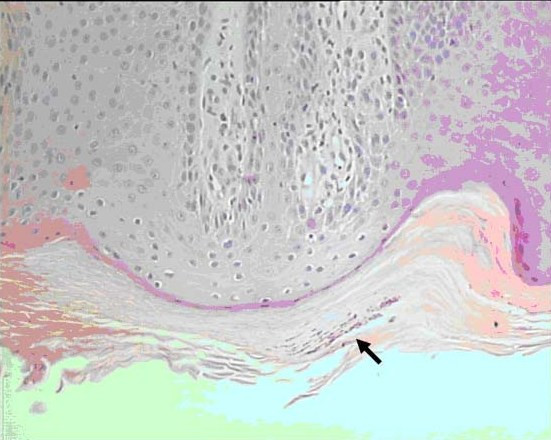
A skin biopsy reveals acanthosis of epidermis, with elongated rete ridges, thin suprapapillary epidermal plates, absent granular layer and hyperkeratosis. A Munro microabscess (arrow) is also noticed within the parakeratotic cornified layer. (Haematoxylin & Eosin, original magnification ×100).